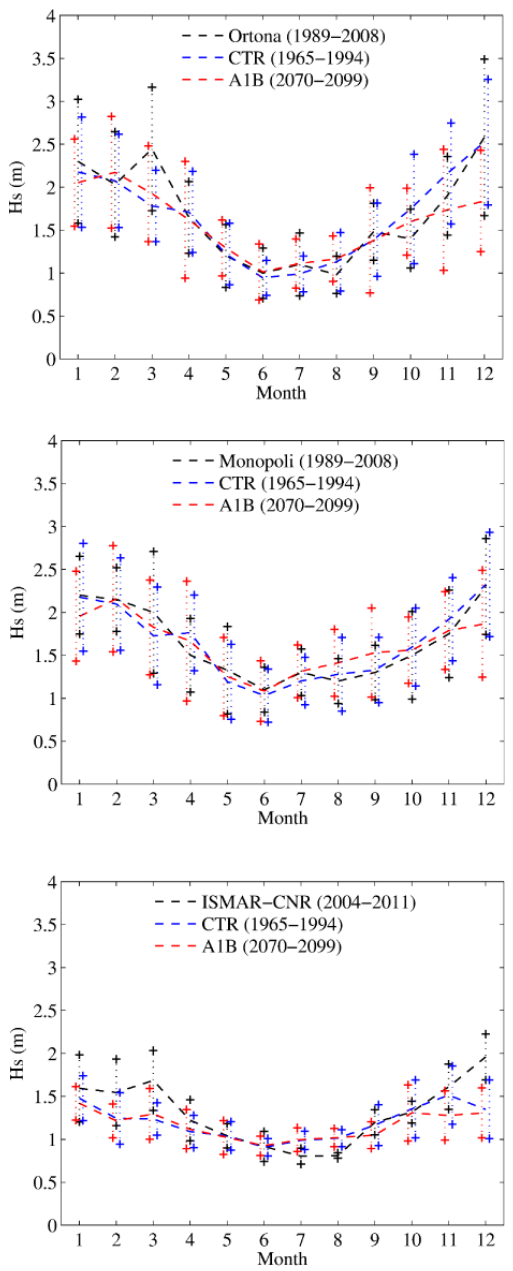
Fig. 3. Monthly 95th percentile H s comparison between modeled (blue: CTR run; red: A1B run) and observed data (black) for Or- tona buoy (top), Monopoli buoy (center), and ISMAR-CNR plat- form (bottom). The vertical bars show the standard deviations of every entire dataset (for graphic purposes, CTR and A1B run data are slightly horizontally